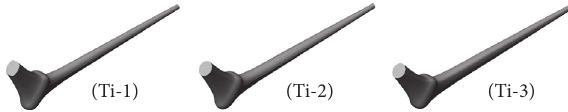
Figure 10: Optimal designs for the Titanium